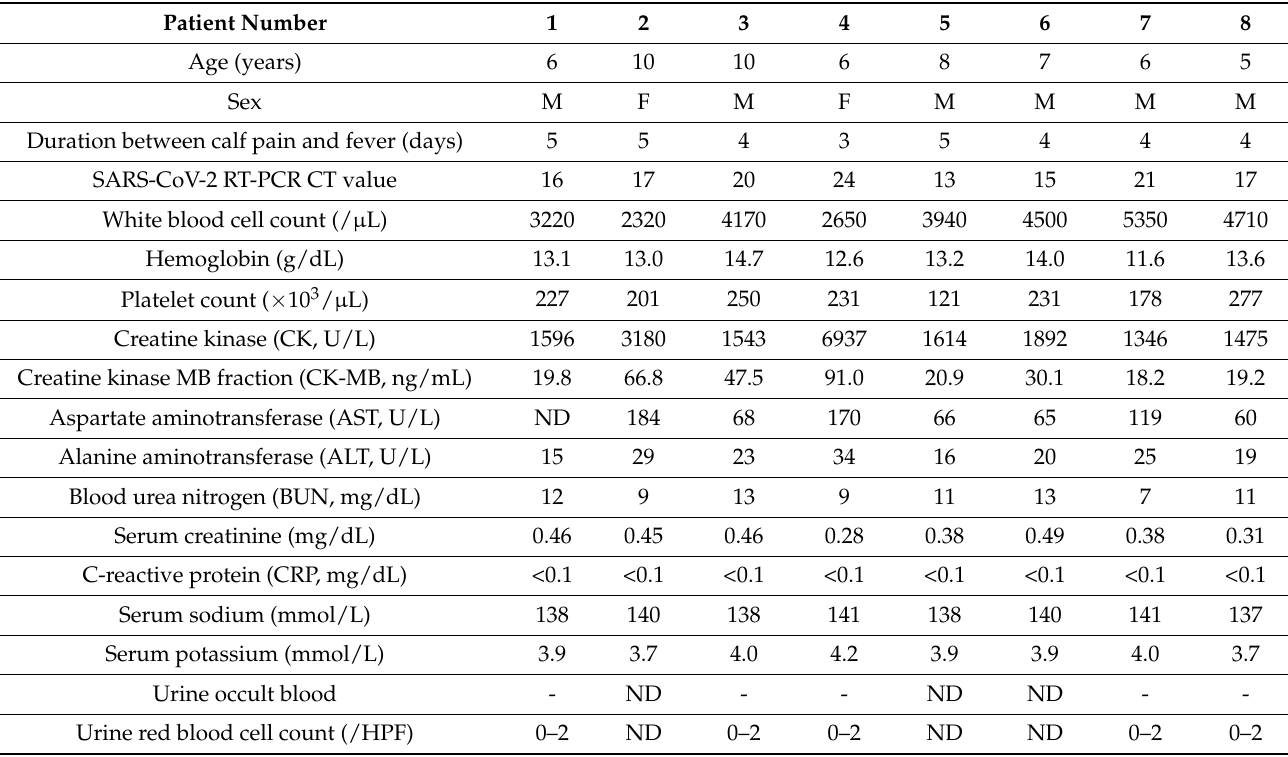
Table 1. Demographic and baseline laboratory data of pediatric patients with rhabdomyolysis after omicron-SARS-CoV-2 infection.